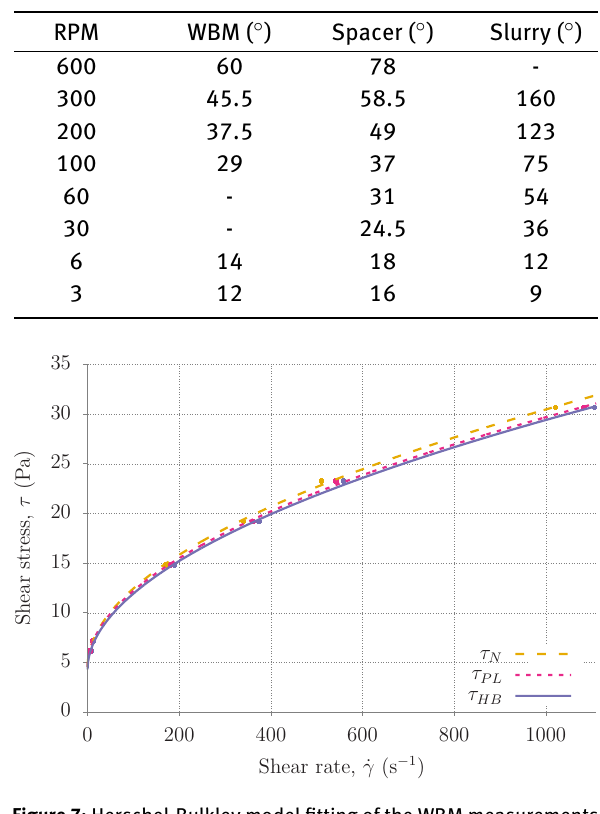
Figure 7: Herschel-Bulkley model fitting of the WBM